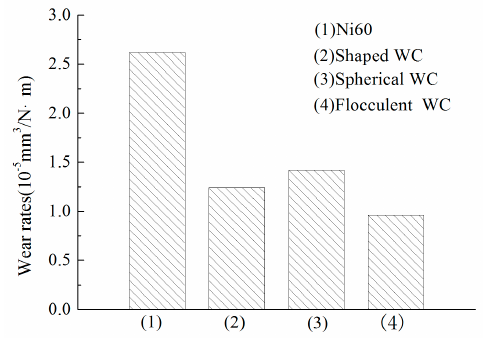
Figure 5. The volume wear rates of the cladding coating.